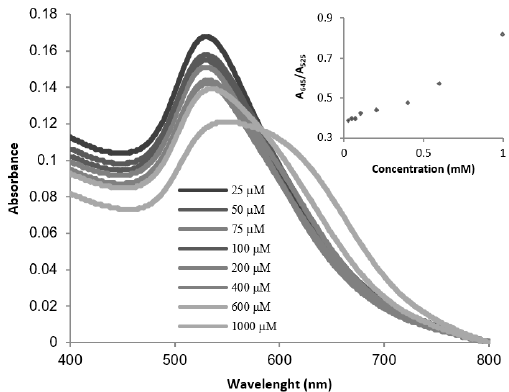
Figure 4. UV-vis absorption spectra of AuNP-1 (10 -9 M, in Tris-HCl 0.01 M, pH 7) in the presence of increasing amounts of aqueous formaldehyde. Inset: Plot of the absorption ratio (A 645 /A 525 ) versus aqueous formaldehyde concentration.